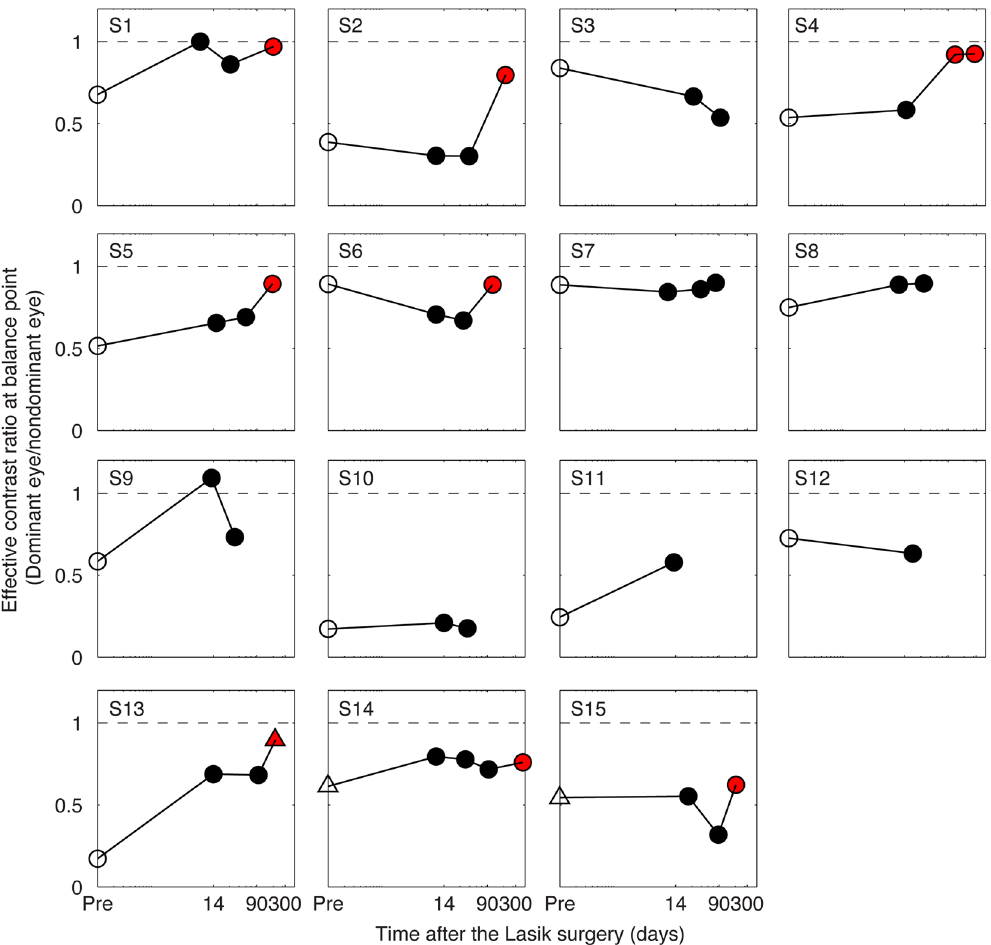
Figure 2. Patients’ sensory eye dominance before and after the surgery. Patients’ sensory eye dominance were quantified by individuals’ effective contrast ratio at balance point (i.e., the interocular contrast ratio that is needed when the two eyes are balanced in binocular phase combination) before and after surgery. The pre- surgery measurement is marked as open symbols; the post-surgery measurement that was measured within 16 weeks after the surgery is marked as black filled symbols and the post-surgery measurement that was measured at or longer than 16 weeks after the surgery is marked as red filled symbols. Except subjects S13, S14 and S15, who had a switch of eye dominance in one of the test sessions (marked as triangle symbols), most observers had consistent nondominant eye during this